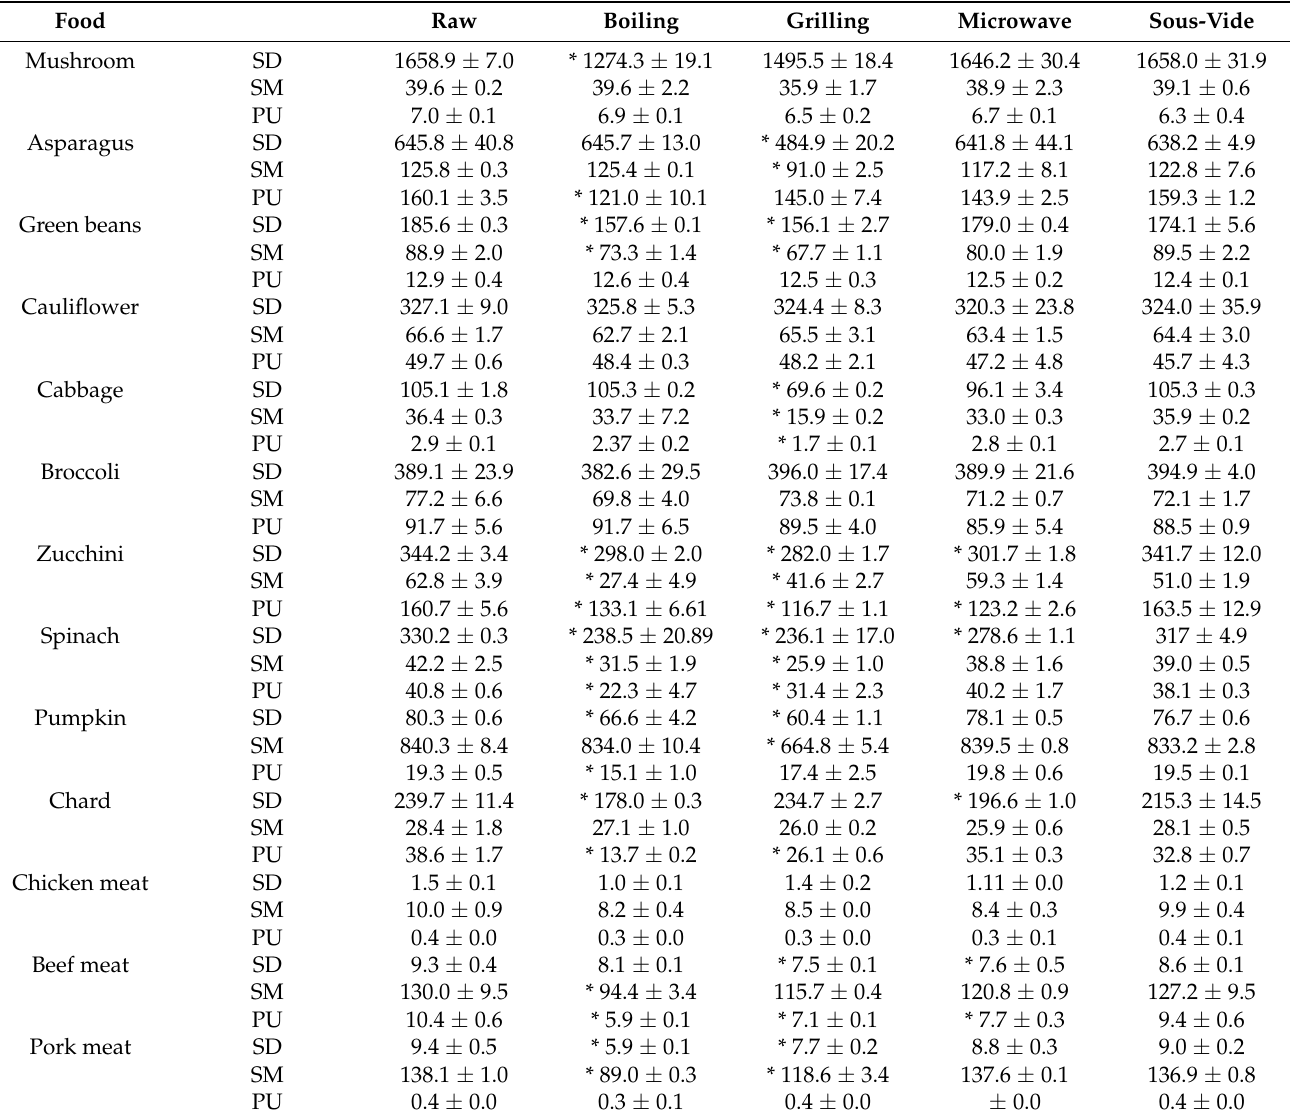
Table 2. Polyamine content (mean ± SD) in mg/kg of dry matter of foods subjected to different culinary processes: raw (control), boiling, grilling, microwave and